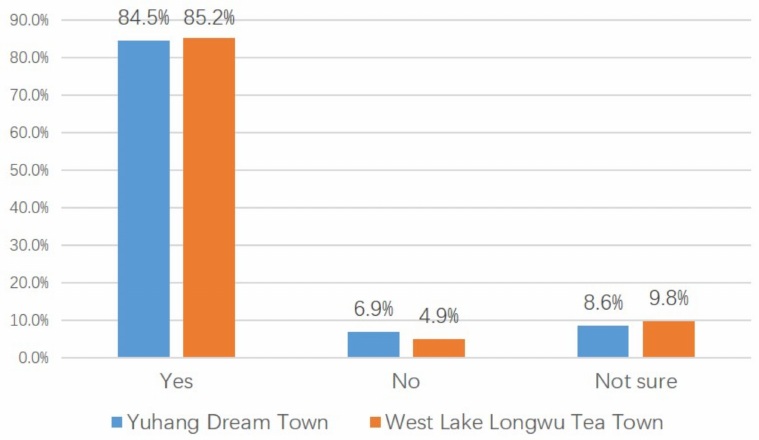
Figure 10. Respondents’ opinions on whether their living standards have been improved in the CT practice (source: